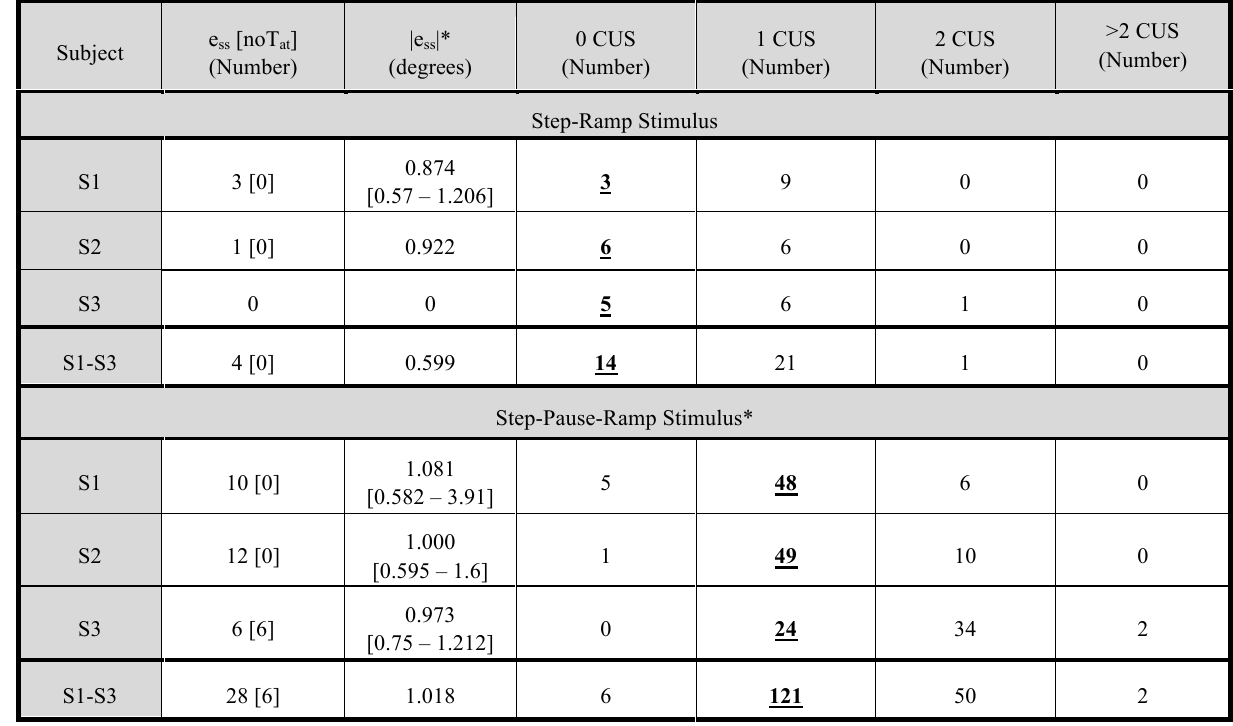
Table 2. Steady-State Errors (>±0.55°) and Catch-up